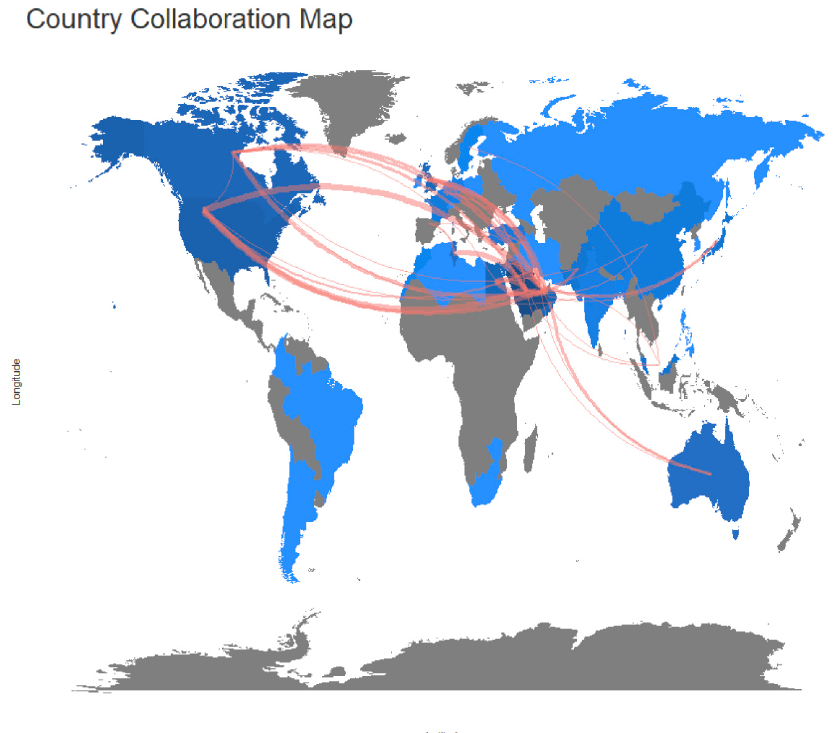
Figure 5. Global collaboration in road traffic injuries research among nations. (generated using Biblioshiny Software R Package).